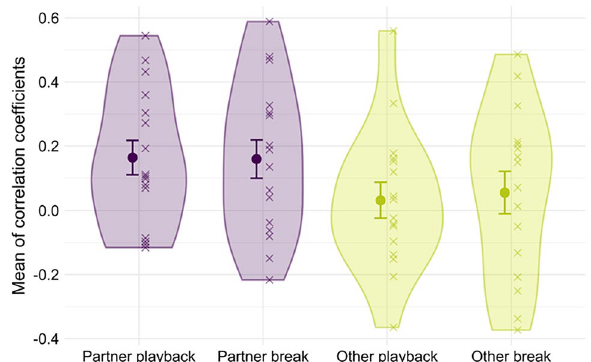
Figure 6. Exploratory analysis of the mutual influence of performers . Mean (•) and individual ( ×) values of Pearson’s correlation coefficients between the mean asynchronies of “real pairs” (ensemble partner) and “stranger pairs” (participants from different duos matched as control condition) during play-along and breaks. Values higher than zero suggest reciprocal influence. The violin plots show the probability density of the data. Error bars represent + / − 1 SE